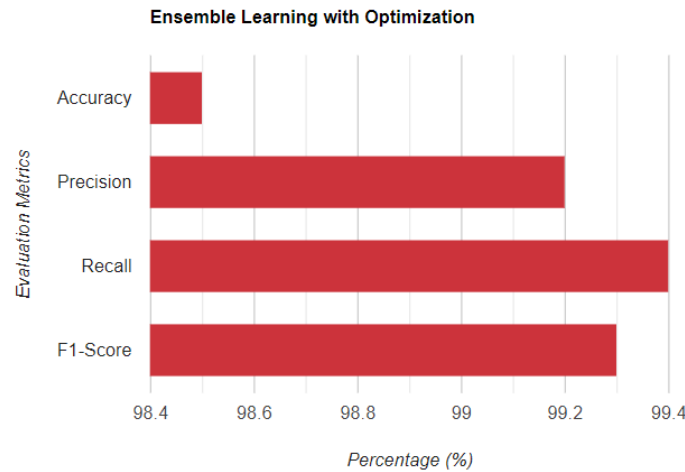
Figure 17. Ensemble Learning After